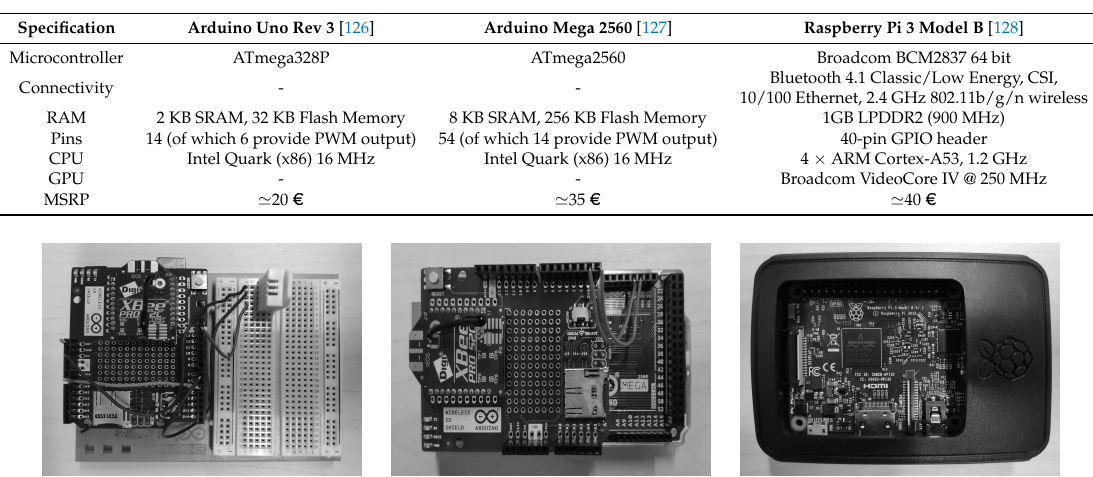
Figure A1. From left to right, the utilized Arduino Uno with the attached Digi XBee-PRO S2C module and DHT22 Temperature and Humidity Sensor, the Arduino Mega with its Digi XBee-PRO S2C module and microSD card slot, and the Raspberry Pi 3 Model B enclosed in a protective